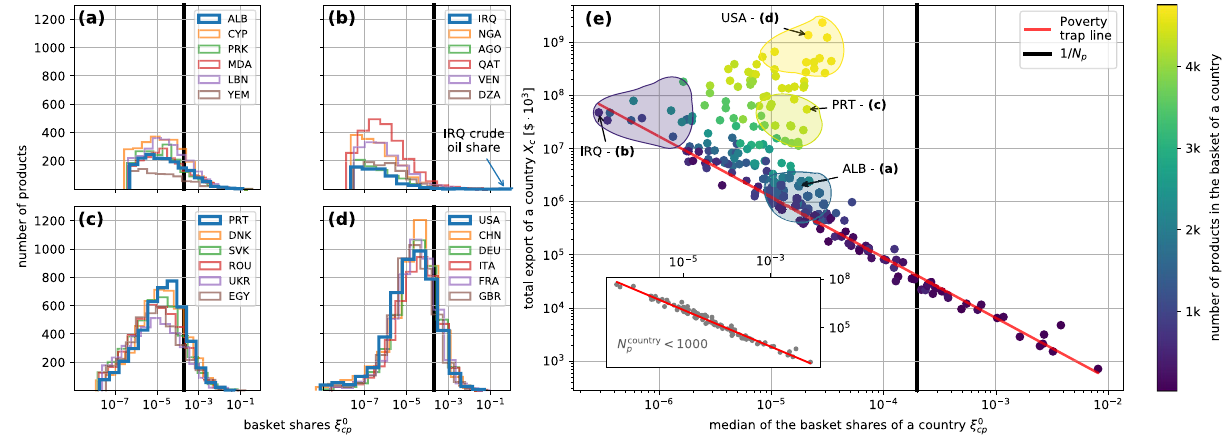
0 Figure 2. ( a–d ) Examples of histograms of the 2015 basket shares ξ cp for different countries grouped among underdeveloped ( a ), oil dependent ( b ), semi-developed ( c ) and fully developed ( d ). Albania (ALB), Iraq (IRQ), Portugal (PRT) and the USA will serve as representative examples of these categories throughout the text (country codes follow ISO-3166 standard 31 ). ( e ) Median of the distribution of the shares vs. total export of a country, colored with respect to the number of exported products. The colored areas show the locations of the four groups of countries whose histograms are reported in ( a–d ). In the inset we highlight the countries exporting less than 1000 products defining a “poverty trap” area. The red line is a linear regression performed over such countries in log-log